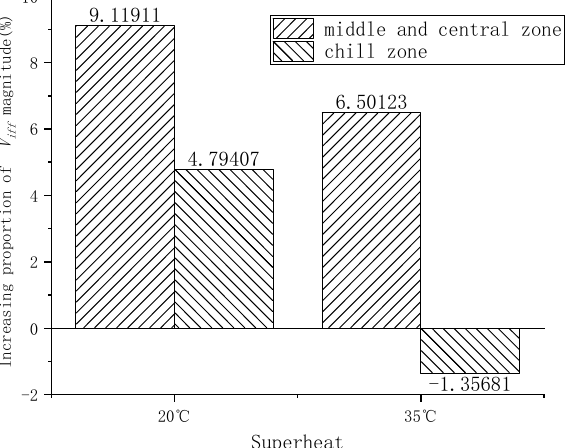
Figure 18. Increasing proportion of average magnitude of interdendritic fluid flow velocity V if f of the inner curve side compared to that of outer curve side at different zones.